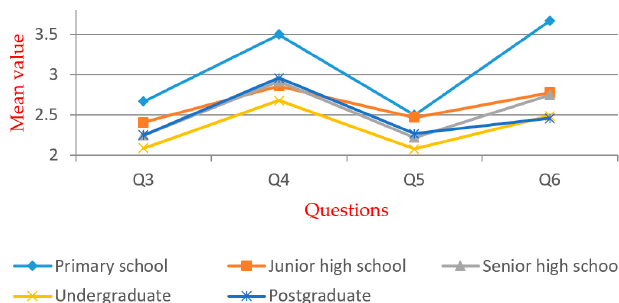
Figure 7. Mean values of “age” group.